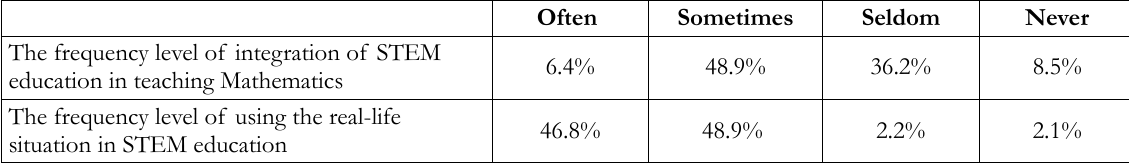
Table 1. The frequency level of integration of STEM